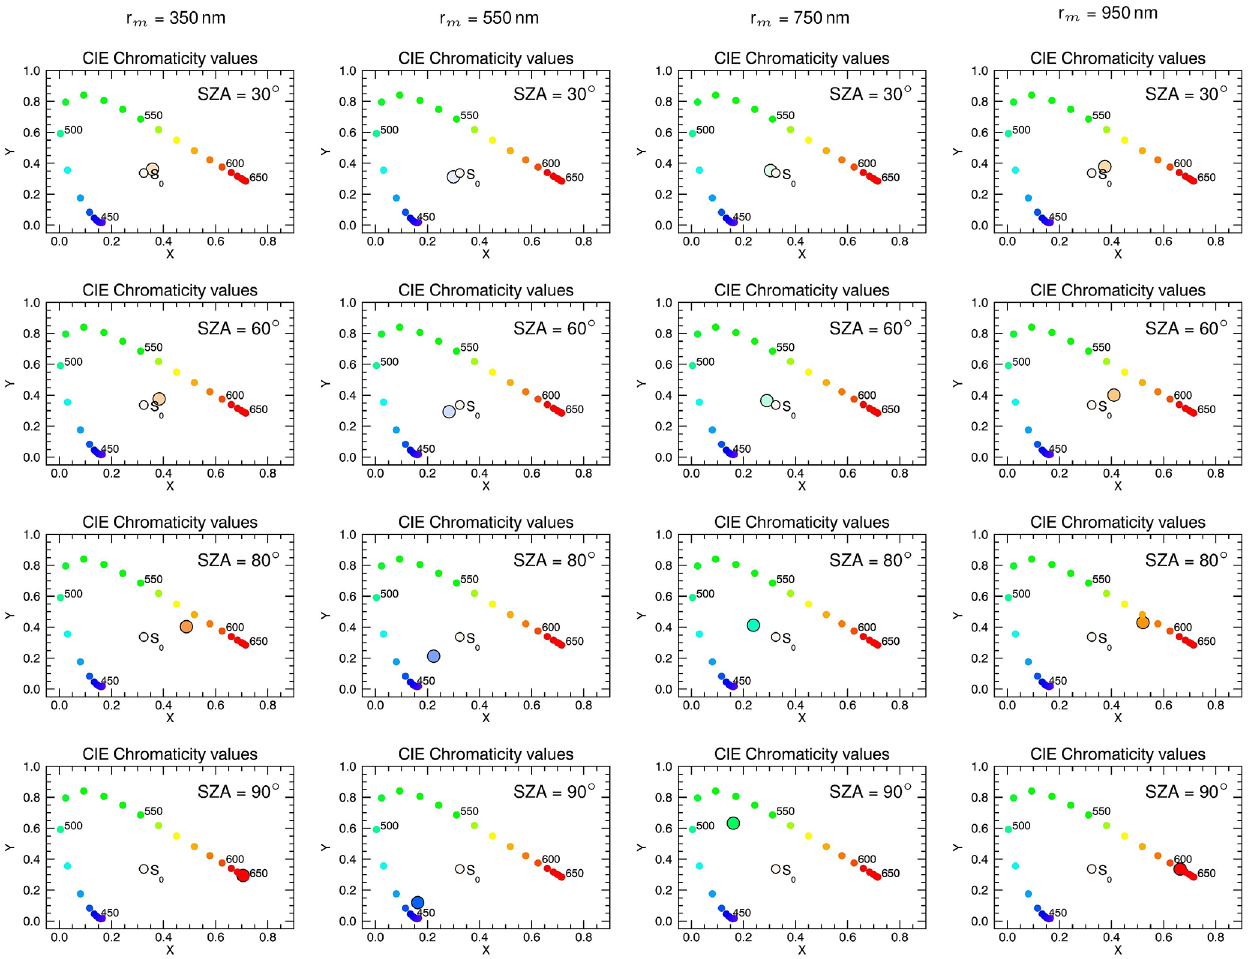
Figure 5. Chromaticity diagrams for different combinations of SZA and median radius r m of the mono-modal log-normal particle size distribution. Results for SZAs of 30, 60, 80 and 90 ◦ are shown in the different rows of the figure, whereas the columns show results for r m of 350, 550, 750 and 950nm. All results are for a distribution width of S = 1 . 05, a real part of the refractive index of 1.4, aerosol optical depth of τ = 1 and an aerosol layer in the 6–8km altitude